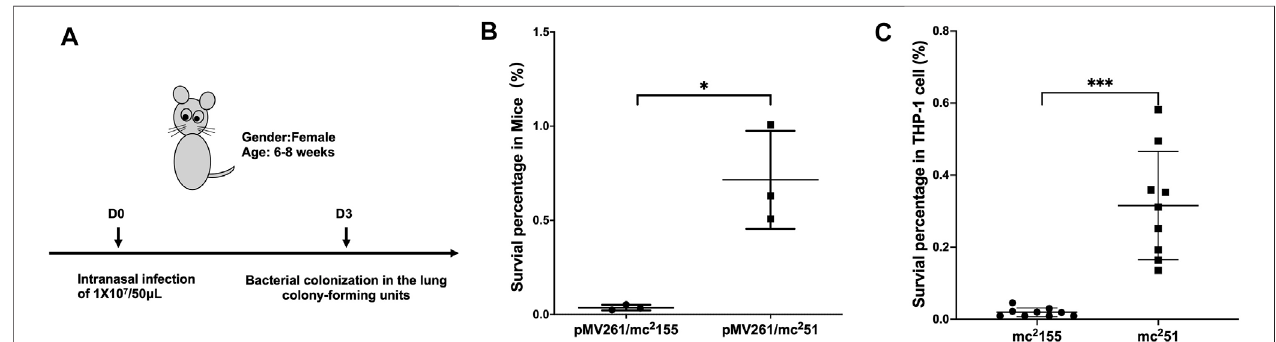
FIGURE 1 | M. smegmatis mc 2 51 displayed improved virulence in mice and THP-1 cells. (A) The schematic diagram of the mice infection. C57BL/6 mice were intranasally infected as described in Materials and Methods with ~1 × 10 7 /50 μ l of M. smegmatis mc 2 155 or mc 2 51. At the 3rd day after infection, the whole lung homogenates were plated to determine bacterial numbers. (B) The H 2 O 2 -resistant mutant strain mc 2 51 has a signi fi cantly higher bacterial load in the infected lung. The lung burdens 3 days after infection with mc 2 155 (black circles) or mc 2 51 (black squares) were measured, and thesurvival percentage was calculated asdescribed in MaterialsandMethods .Eachgroupconsistedofthreemice.* p < 0.05. (C) TheH 2 O 2 -resistantmutantstrainmc 2 51hasasurvivaladvantageoverwild-typemc 2 155in themacrophage-likecelllineTHP-1.THP-1cellswereinfectedwithmc 2 155(blackcircles)ormc 2 51(blacksquares)atamultiplicityofinfectionof1 hafterinfection,THP- 1 cell lysates werecollected, and the intracellular bacilli were measured, and the survival percentage was calculated as described in Materials and Methods . Each group consisted of nine repeats. *** p <